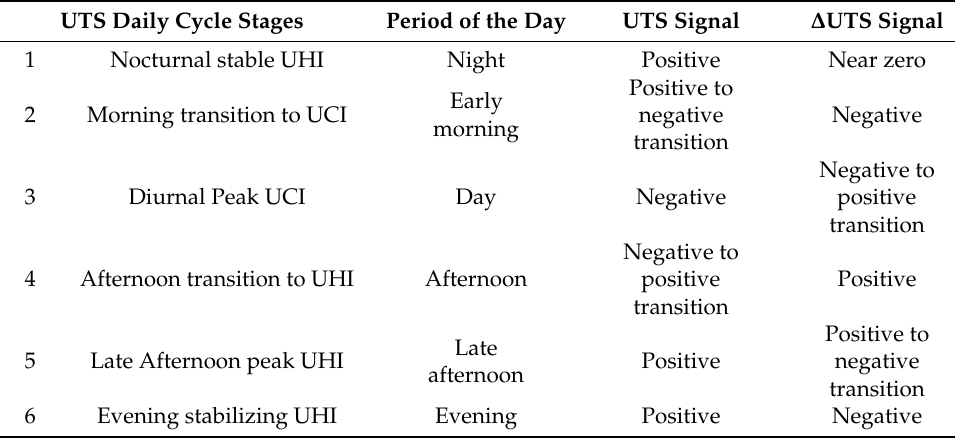
Figure 5. Diagram of the UTS daily cycle stages: the solid and dashed lines show the hourly intensities of the UTS and ∆ UTS in Lisbon city center, respectively. These correspond to a smoothed version of the RES site median values (3 h moving average). Table 5. Classification criteria of the UTS daily cycle stages in